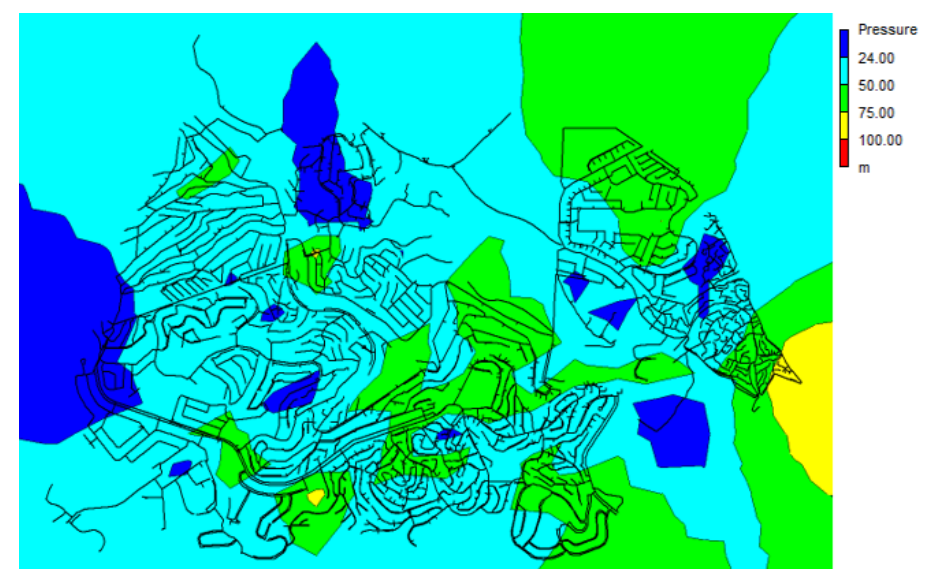
Figure 3. Pressure head in WDN with no PATs installed.